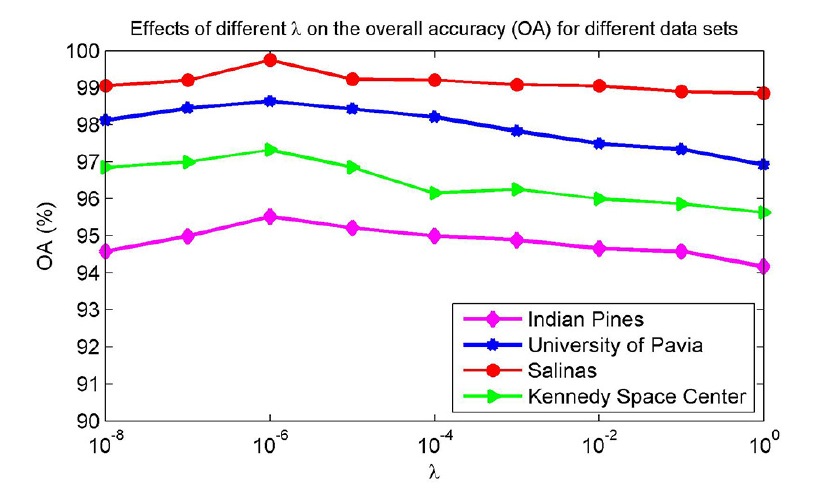
Figure 6. Effects of the regularization parameter λ on the overall accuracy (OA) for four different data sets.